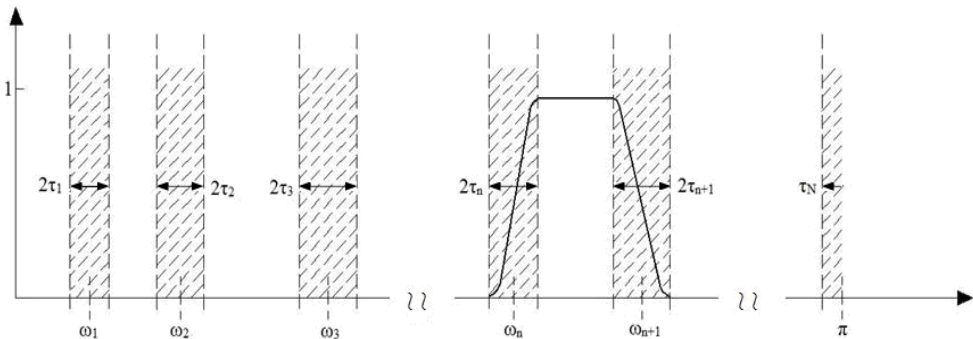
Figure 1. The interval division of Fourier axis.